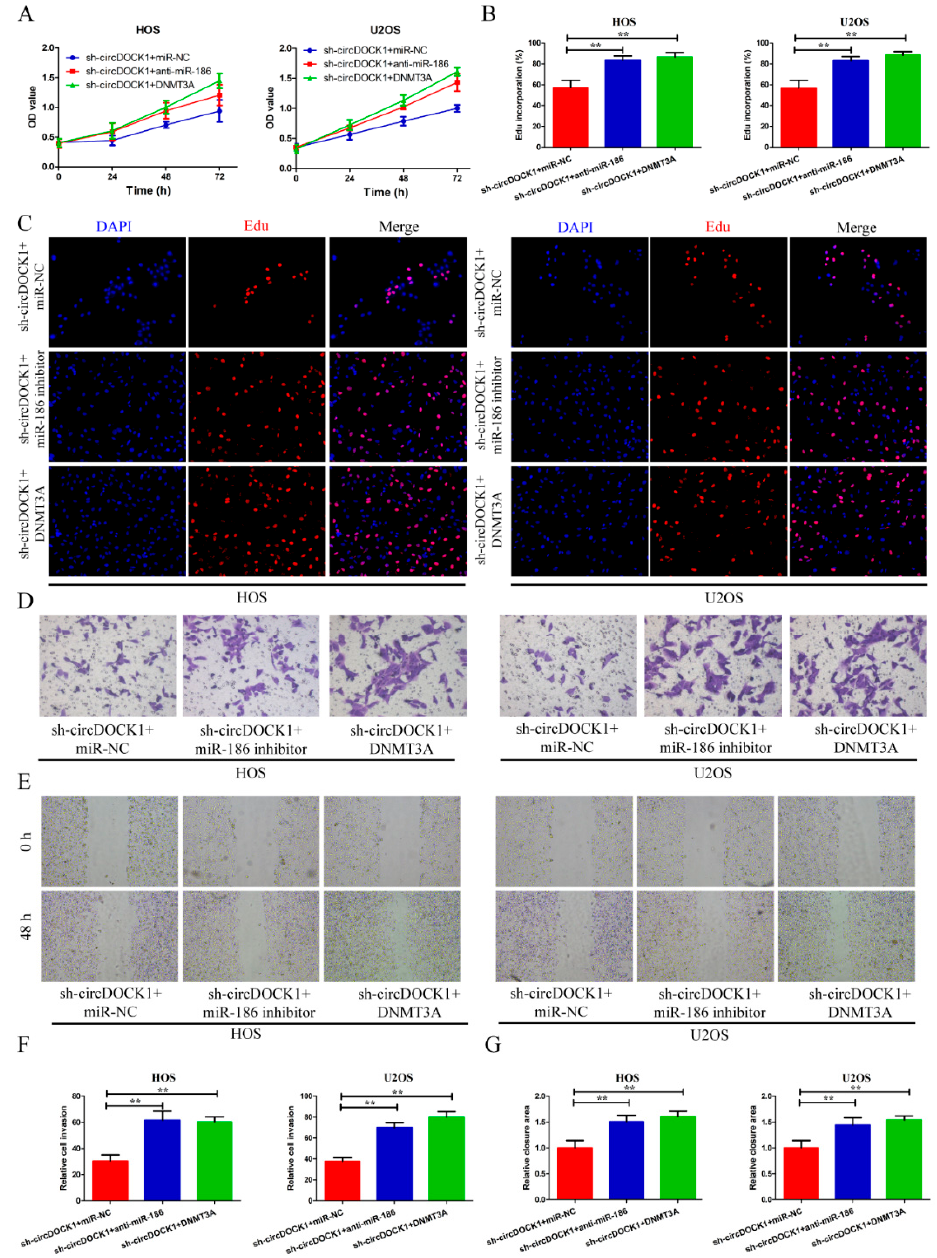
Figure 6. CircDOCK1 regulates OS progression through the miR-186/DNMT3A axis. ( A – C ) After co-transfection, the cellular proliferative potential was examined via CCK-8 and EdU assays. ( D – G ) Wound-healing and Transwell assay outcomes for cellular motility and invasion. ** p < 0.01.